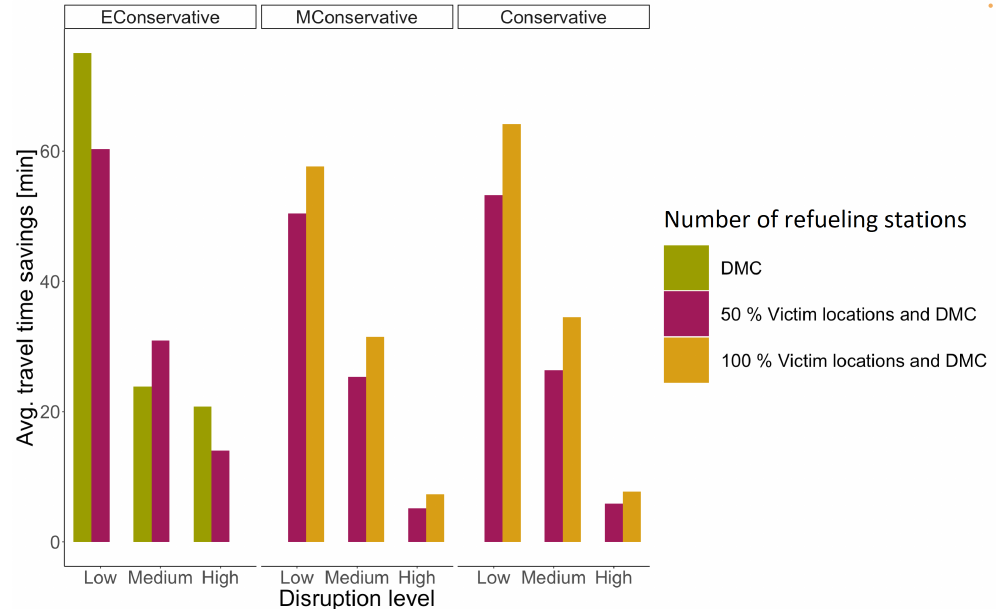
Figure 14. Cluster C: impact of the number of refueling stations on the performance of refueling